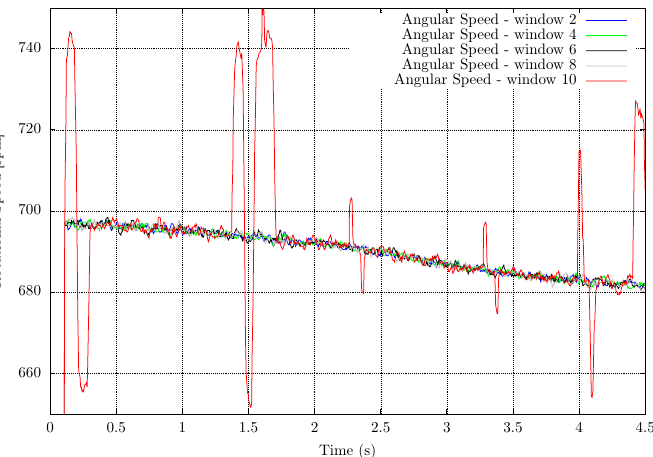
Figure 6. Event-based Angular Speed Measurements applied for a rotating fan varying the Kernel size. Table 2. Amount of data generated by the sensor at different rotational speeds. Rotation